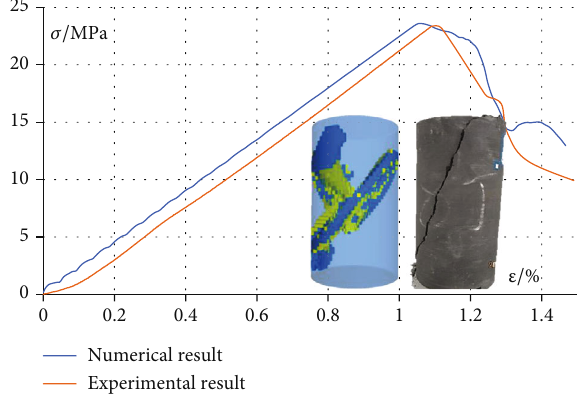
Figure 5: Parameter